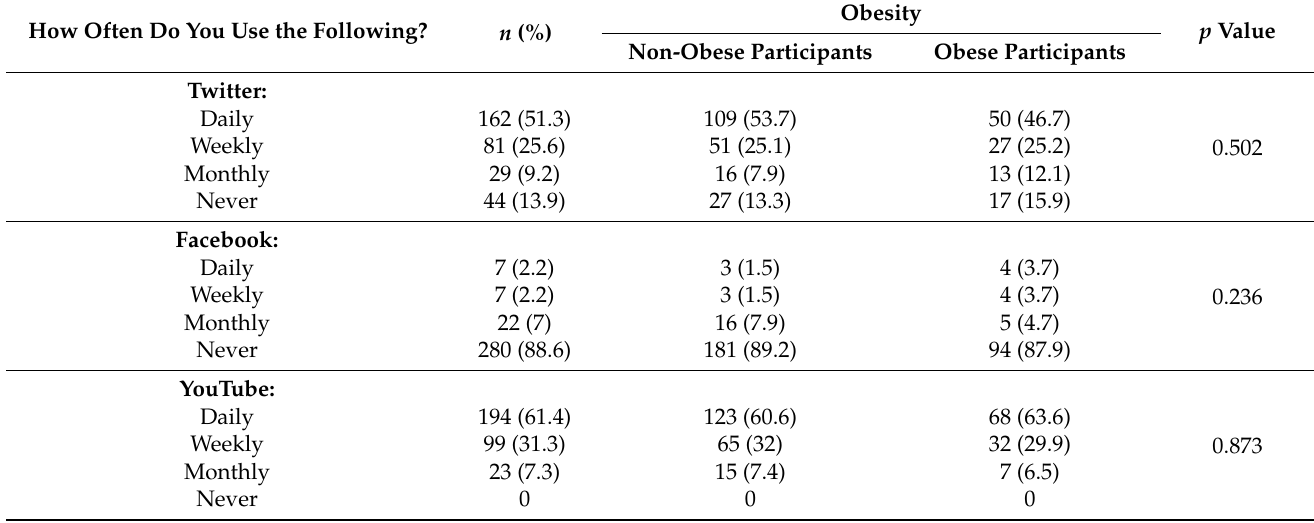
Table 2. Frequency of social media platform usage among the study participants according to their obesity